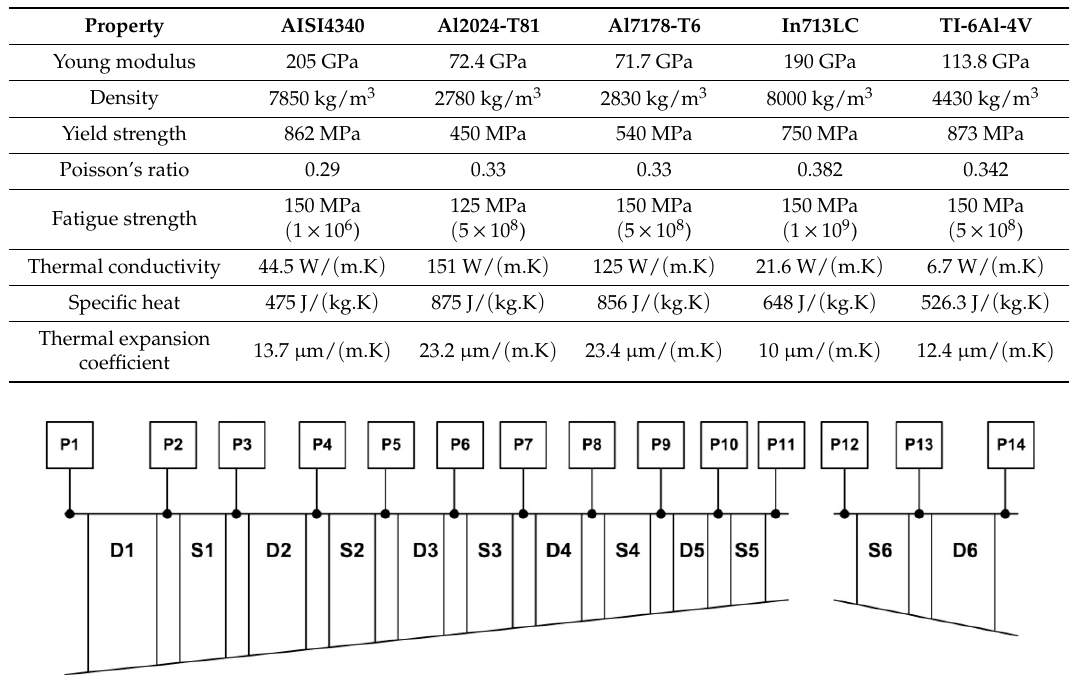
Table 2. Basic properties at room temperature of the high-performance metallic alloys used.